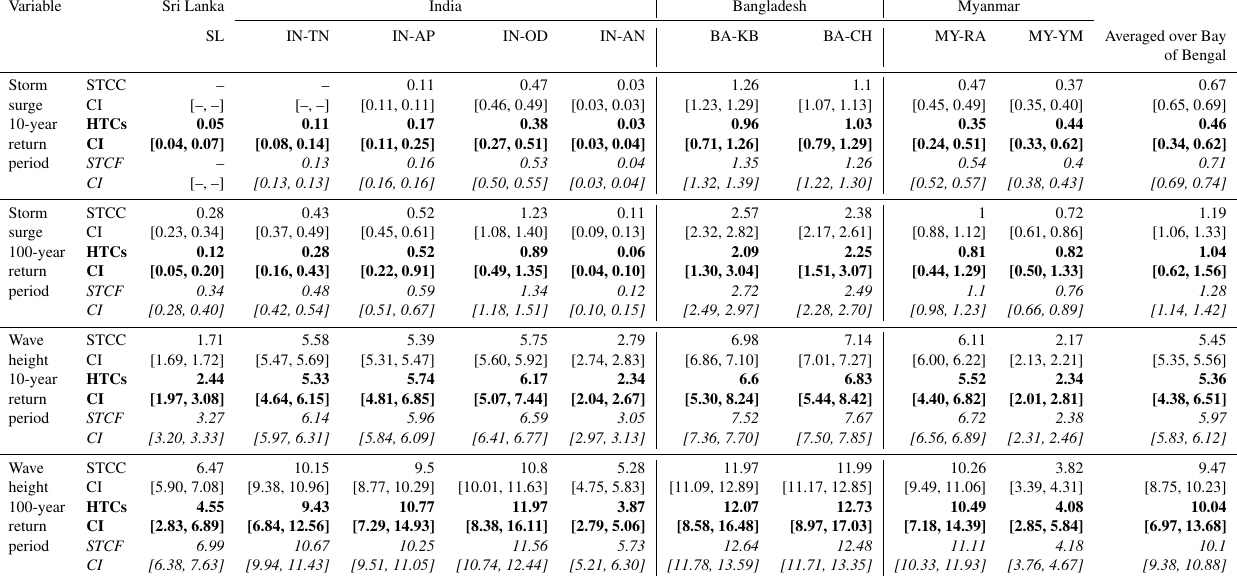
Table 2. Storm surge and significant wave heights estimated based on STCC (regular typeface), HTCs (in bold) and STCF (in italic) including confidence intervals (2.5th, 97.5th), for return periods of 10 and 100 years, averaged over the entire BoB and per region. Regions are as in Table 1: Sri Lanka (whole country), India (TN, Tamil Nadu; AP, Andhra Pradesh; OWB, Odisha and West Bengal; AN, Andaman and Nicobar Islands), Bangladesh (KB, Khulna and Barisal; CH, Chittagong) and Myanmar (RA, Rakhine and Ayeyarwady; YM, Yangon and Mon). A dash (–) is displayed if no 10-year return period could be